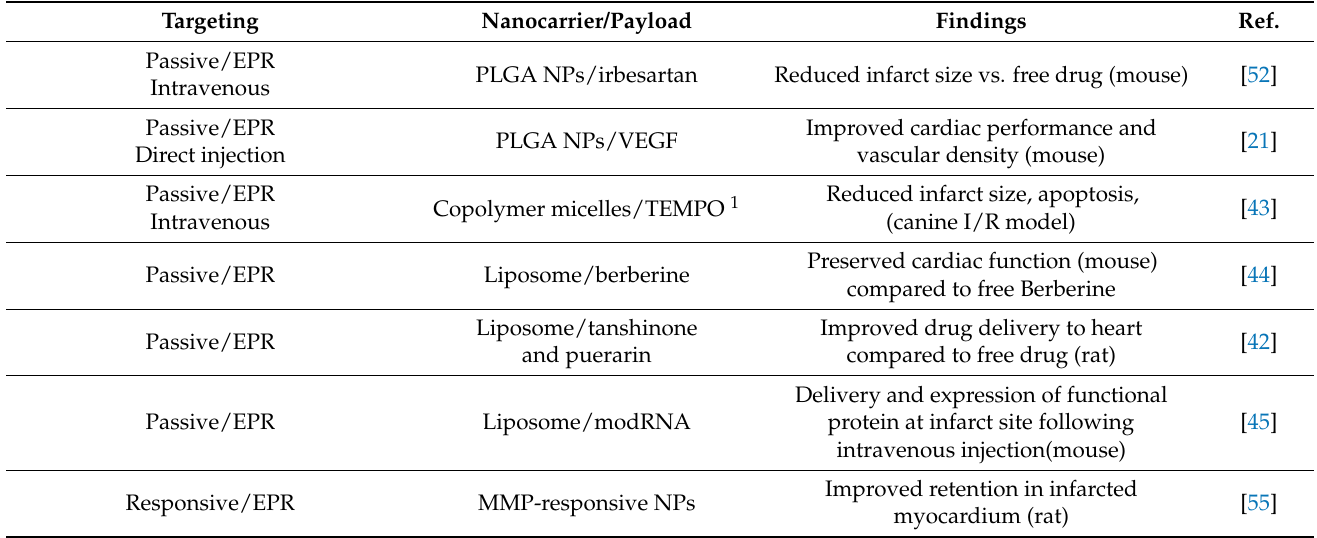
Table 1. Summary of nanocarriers utilized for myocardial infarction